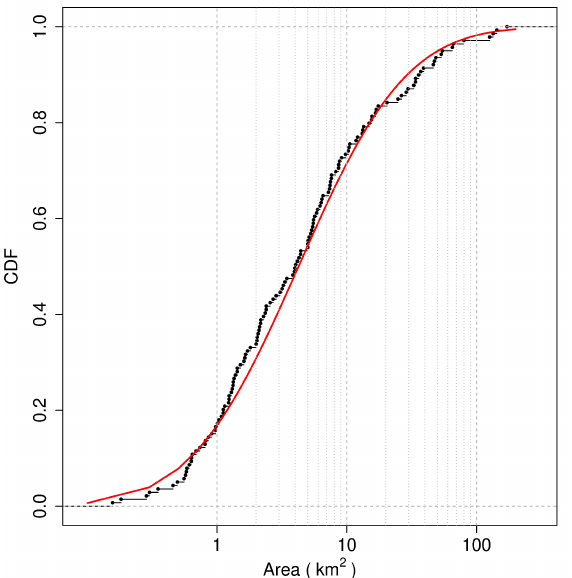
Figure 3. Cumulative distribution function (CDF) of the size of the 139 Metropolitan RTM units in a semi-logarithmic graph. The red curve shows the most likely log-normal